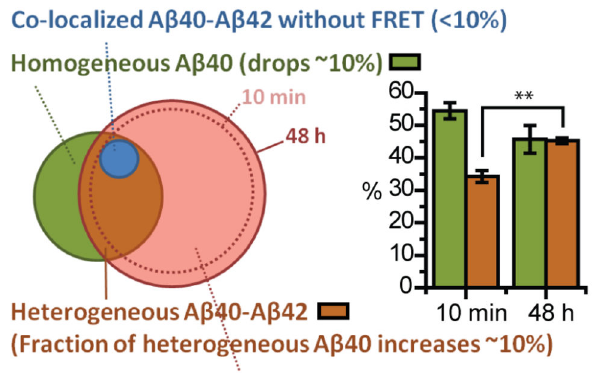
Figure 5. Diagram of the number of Aβ40 and Aβ42 oligomers on the neurites. The color assignments are the same as in Figure 4. Green and red circles represent the total number of Aβ40 and Aβ42 species respectively (including both homogeneous and heterogeneous species). The overlap region of the two circles (brown area) represents the heterogeneous species. And the blue circle inside the brown area represents those heterogeneous species that do not show FRET signal. At 10 minutes, there are slightly more Aβ42 species than Aβ40, therefore larger red circle. By 48 hours, the number of Aβ40 species remains similar; therefore the green circle remains the same. The number of Aβ42 species increases over 48 hours (the dashed red circle depicts the population at 10 minutes). Since additional Aβ42 also binds to homogeneous Aβ40, the fraction of heterogeneous species among Aβ40 increase (unpaired two-tailed t-test, **P < 0.05), and the fraction of homogeneous Aβ40 decreases over 48 hours.